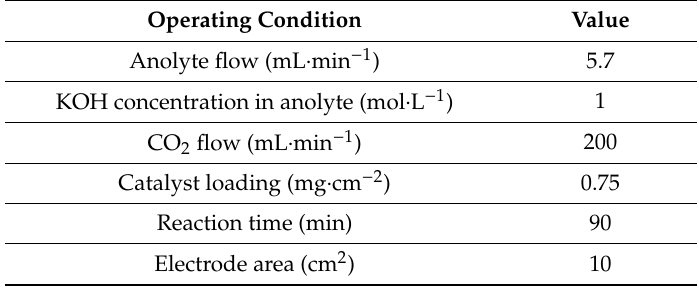
Table 5. Value of the di ff erent operating conditions taken in the references